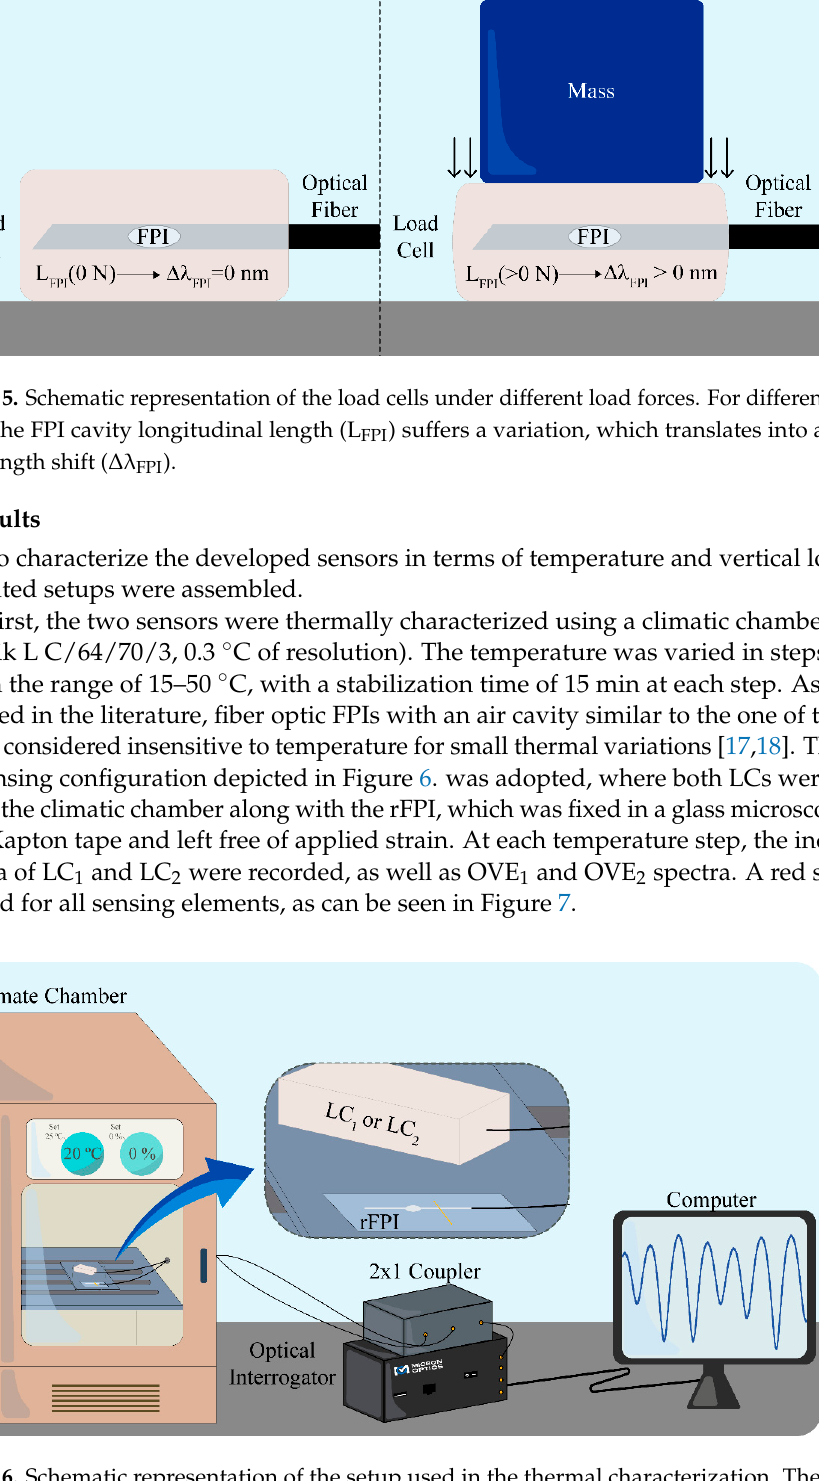
Figure 6. Schematic representation of the setup used in the thermal characterization. The zoom-in depicts the positioning of LC 1 (or LC 2 ) and rFPI inside the climate chamber.